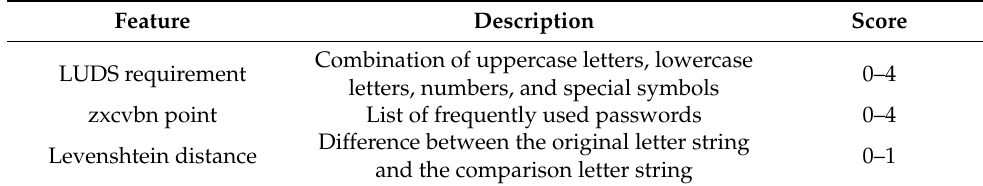
Table 1. Password feature data list.